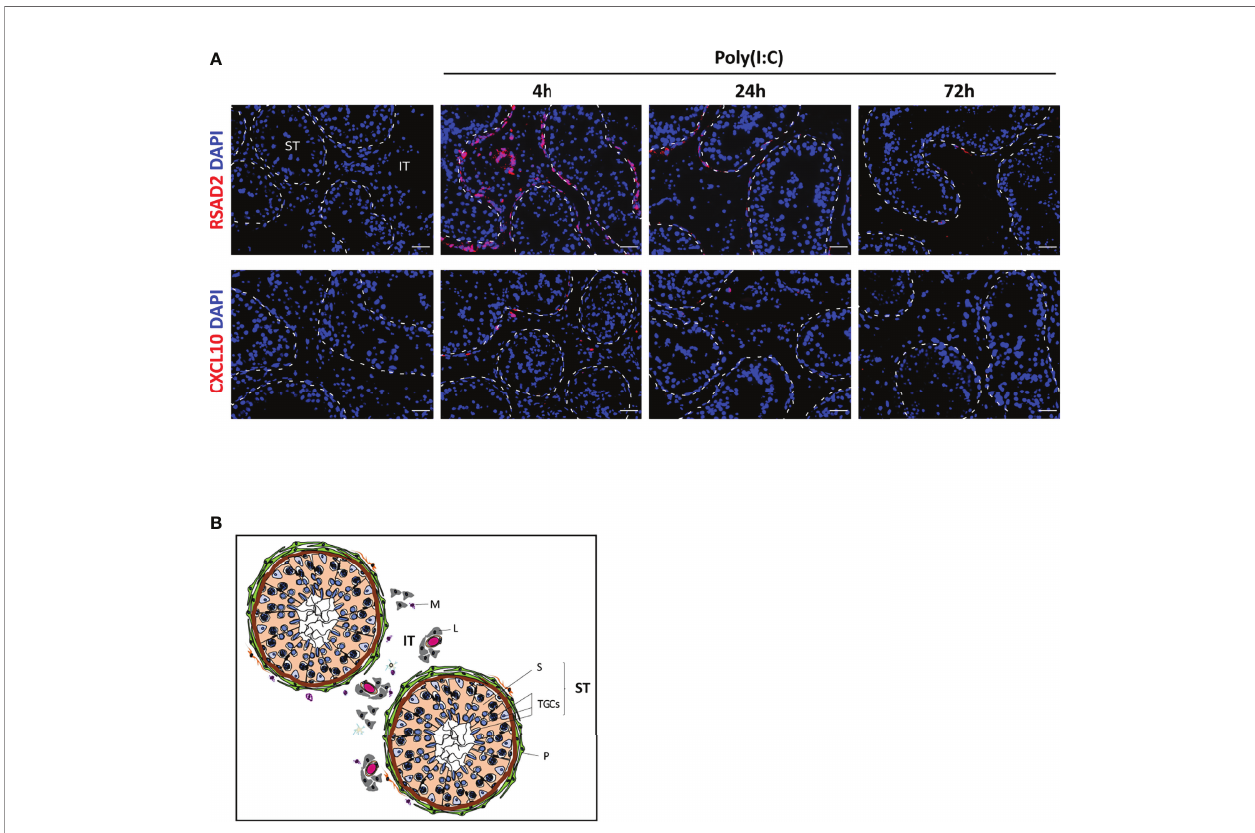
FIGURE 3 | Poly(I:C) responding cells in human testis explants. Antiviral effector RSAD2 or pro-in fl ammatory chemokine CXCL10 were detected by RNAscope ISH in testis explants exposed or not to Poly(I:C) for 4 to 72h (A) . Representative images are shown. Nuclei are stained in blue. The white dotted lines highlight seminiferous tubules borders. Scale bars: 40 µm. Histological structure of the human testis is shown in (B) . The seminiferous tubules (ST) are surrounded by layers of myoid peritubular cells (P) and contain the testicular germ cells at different stages of differentiation (TGCs) embedded in Sertoli cells (S). The seminiferous tubules bath in the interstitial tissue (IT), which primarily contains Leydig cells (L), blood vessels and macrophages